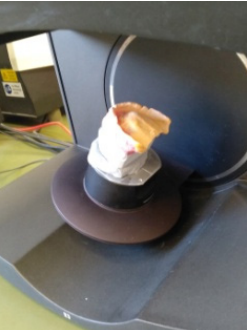
Figure 4. Maxillomandibular records and wash impression scanning in a lab scanner.